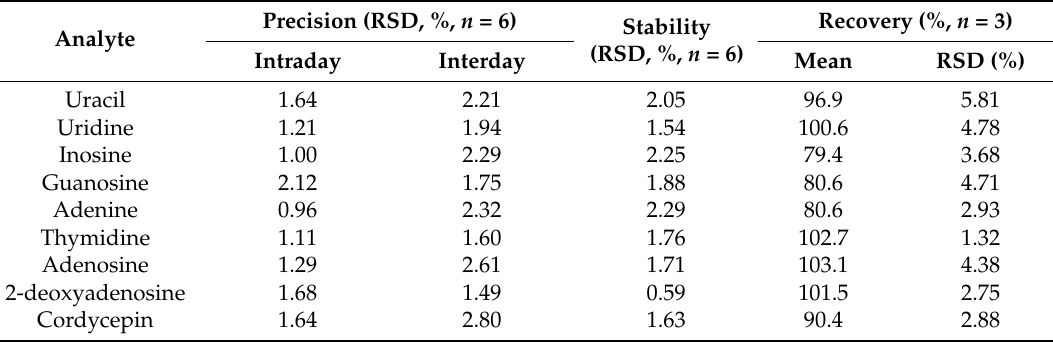
Table 2. Precision, repeatability, stability and recovery of nine